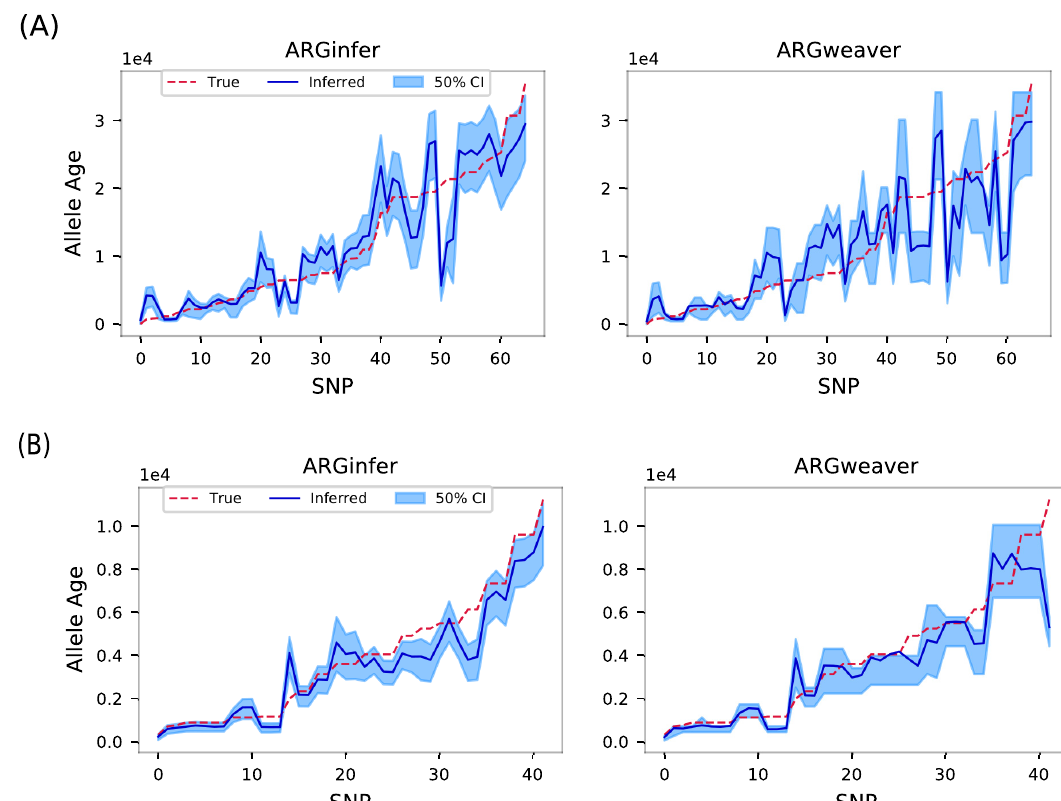
Fig 6. True (red dashed line) allele ages, in units of 10 4 generations, and posterior mean (blue line) inferred by ARGinfer (left) and ARGweaver (right) for the simulated data sets used in Fig 5. Along the x axis SNPs are ordered by increasing value of true allele age. (A) R = 1, (B) R = 4, and blue shading shows 50% credible